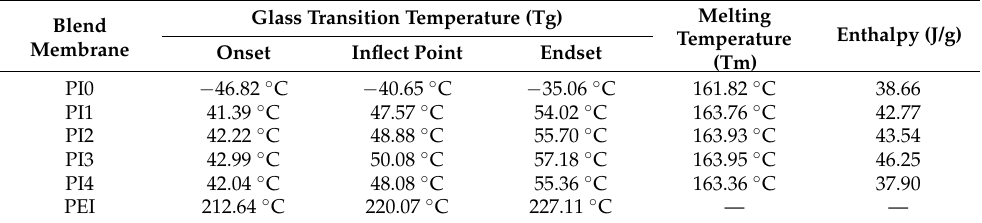
Figure 4. The kind of membrane DSC curves. ( a ) PEI pure membrane, ( b ) pure membrane and blend membrane curves. Table 4. DSC data of blend